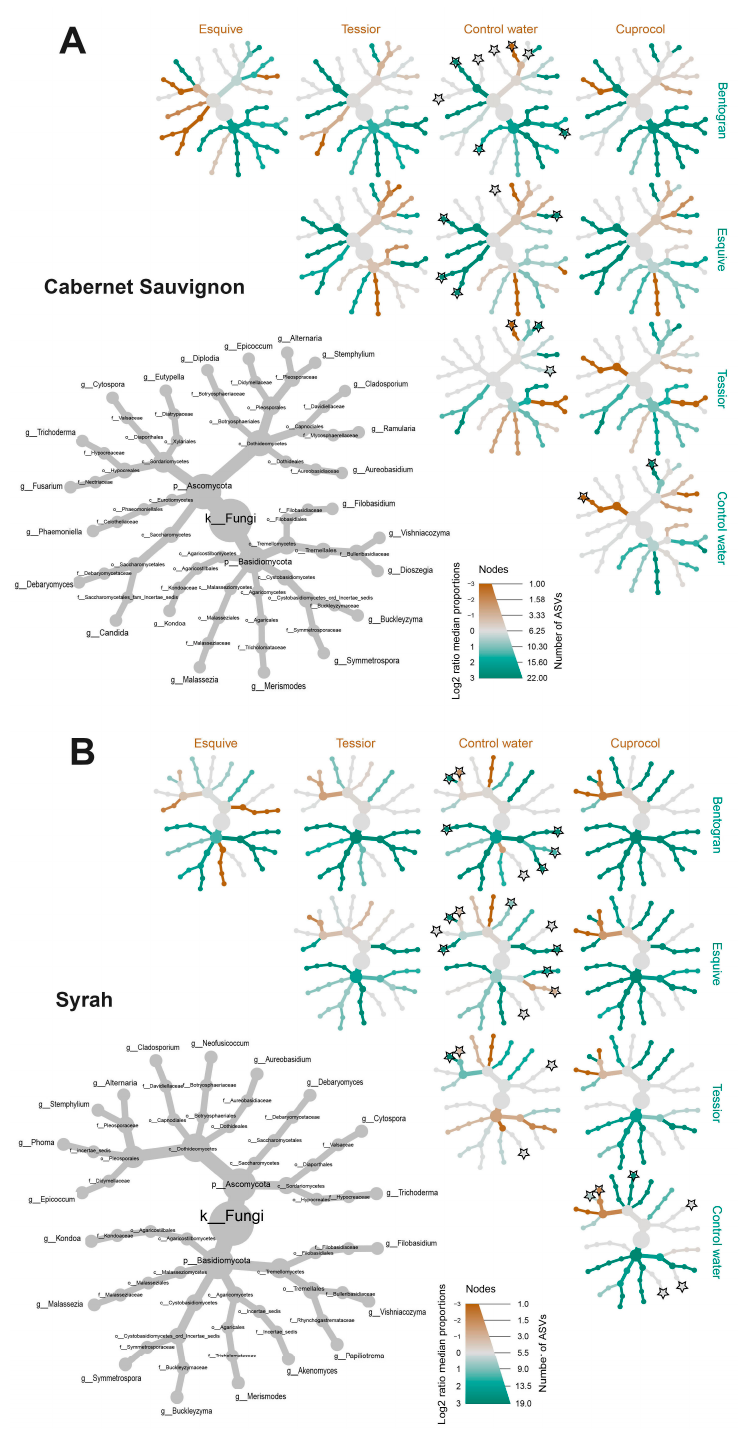
Figure 7. Differential heat tree matrices depicting changes in taxon abundance between different pruning wound protection product treatments (Bentogran, control water, Cuprocol, Esquive and Tessior) in Cabernet Sauvignon ( A ) and Syrah ( B ) from the Almotivo vineyard, represented in the dataset at a relative abundance (RA) > 0.1%. The smaller cladograms show pairwise comparisons between each treatment, with the color illustrating the log2 fold change: a green node indicates a lower abundance of the taxon in the treatment group on the abscissa than in the treatment group on the ordinate. A brown node indicates the opposite. A black star on a node represents statistically significant differences between treatments according to DeSeq2 ( p <